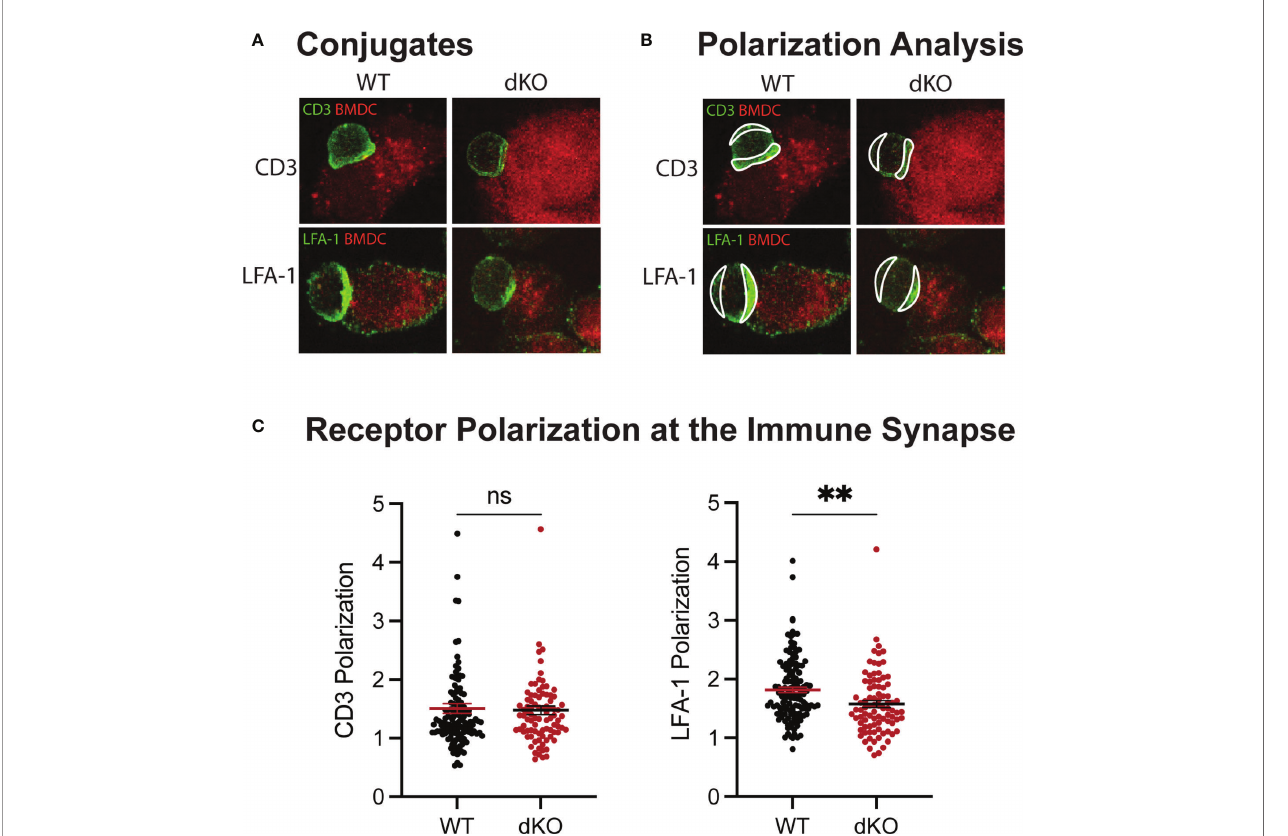
FIGURE 7 | EVL/VASP dKO T cells polarize less LFA-1 at the immunological synapse. Mature, LPS-activated, OVA-pulsed tdTomato-BMDCs were adhered to chamber slides. Naïve WT and EVL/VASP dKO OT-I T cells were added to the chamber slides to form conjugates. Conjugates were then fi xed and stained for CD3 and LFA-1. (A) Example images of conjugates stained for CD3 (top) or LFA-1 (bottom). (B) Examples of regions drawn to assess polarization of receptors at the immunological synapse. (C) Quanti fi cation of receptor polarization at the immune synapse. The mean fl uorescence intensity (MFI) of the contact region at the synapse was divided by the MFI of the region de fi ned at the back of the cell. Each dot represents an individual T cell – APC conjugate, data are pooled from 3 independent experiments. Signi fi cance was assessed by unpaired t test; ns is not signi fi cant, and ** is p <